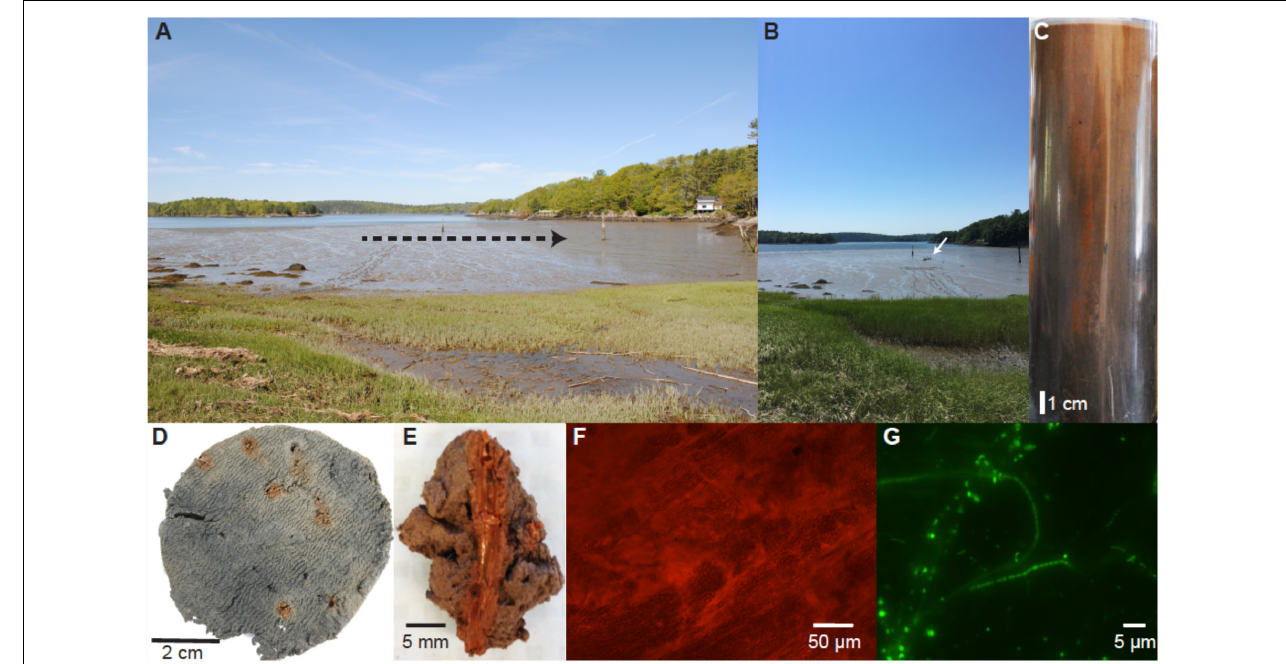
FIGURE 1 | A photomontage of images over different time and spatial scales from seasonal sampling at “The Eddy” (Maine, United States; 43.994827, − 69.648632). A landscape view of the mudflat at low tide ( A ; 26 May 2016) with dashed arrow line depicting the progression of sampling throughout the annual cycle (tracks created from sampling are visible at the position distal to the arrowhead). (B,C) A representative core (18 November 2015) taken from “The Eddy” at the site of the white arrow showing ∼ 20 cm of total sediment showing deep mixing by macrofauna up to ∼ 15–17 cm in depth by visible iron oxides, then the sediments become bluish-gray to black. A one-centimeter core slice from 5 cm depth (D) showing characteristic iron oxide lined worm burrows most likely created by the common polychaete Nereis diversicolor and/or the intertidal inhabiting hemichordate Saccoglossus kowalevskii . Close up image of a dissected iron oxide lined burrow ( E ; 28 December 2015) and light microscope image of burrow lining at 400x magnification (F) . Fluorescence microscope image of DNA stained microorganisms inhabiting the iron oxide burrow lining ( G ; 8 October 2015). Filamentous Beggiatoa spp. (thick filament) And putative “cable bacteria” (thin filaments) were commonly observed throughout the